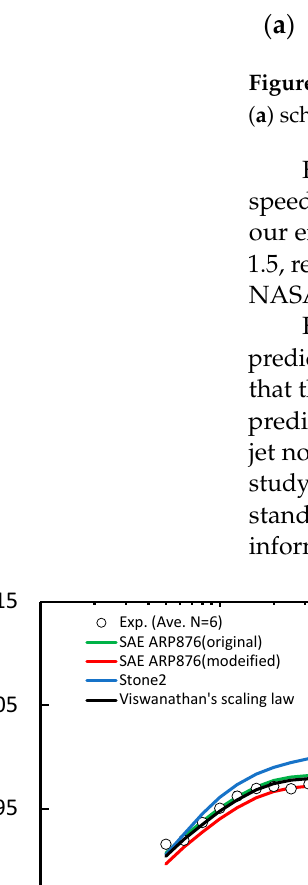
Figure 7. Comparison between the predicted and measured jet noises for single-engine operation at N1 = 95%, jet velocity =322 m/s, and TTR = 1.5: ( a ) θ = 90°; ( b ) θ = 150°.